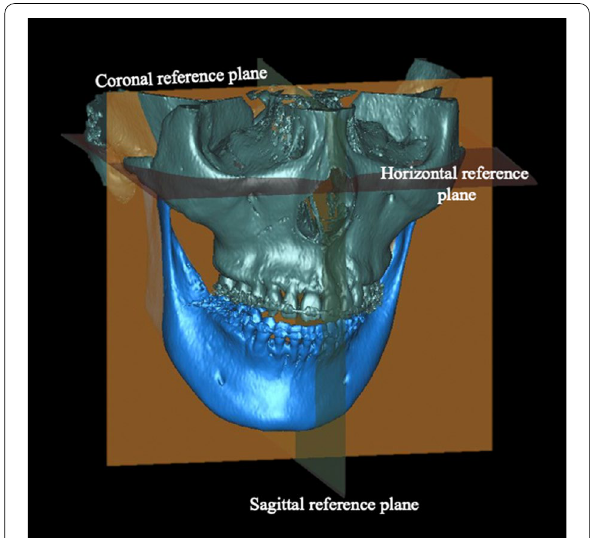
Fig. 1 Three‑dimensional computed tomography image of a patient with mandibular asymmetry with menton deviation greater than 4 mm from the mid‑sagittal